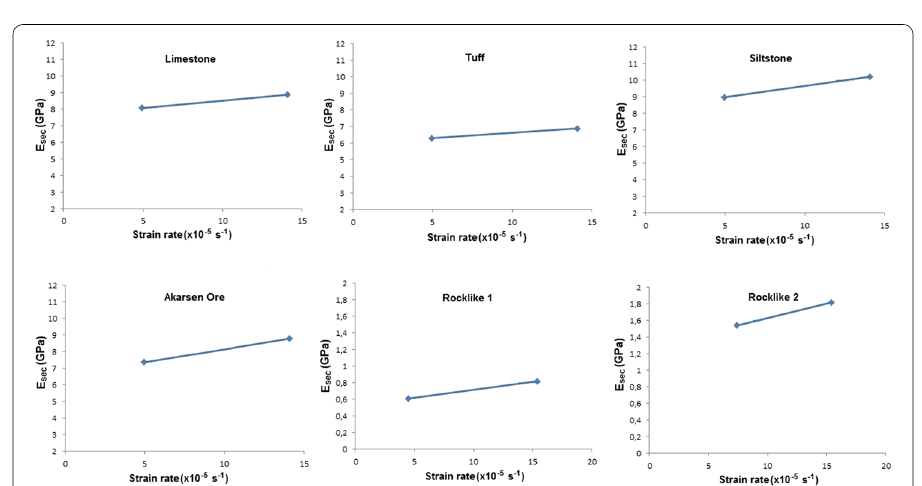
Fig. 8 Secant modulus of elasticity